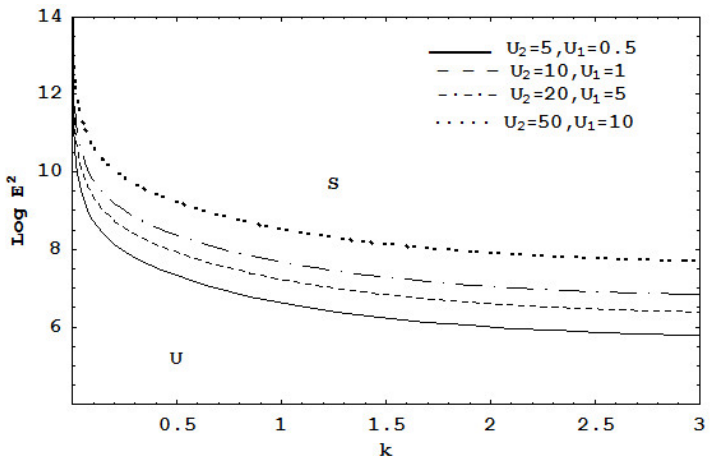
with wavenumber k for different values of the 0